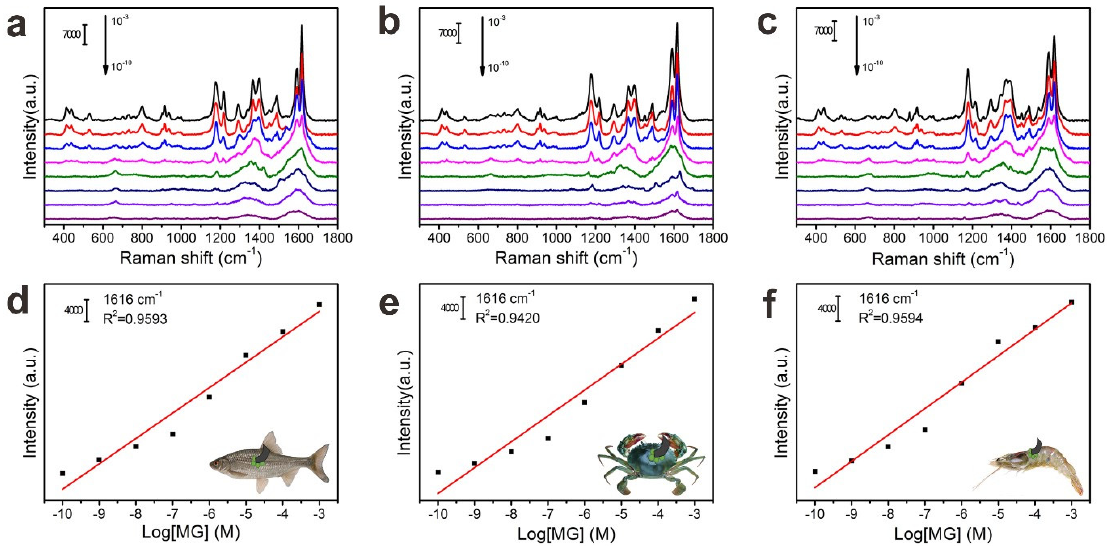
Figure 7. Spectra of MG with 10 − 3 M, 10 − 4 M, 10 − 5 M, 10 − 6 M, 10 − 7 M, 10 − 8 M, 10 − 9 M and 10 − 10 M concentrations collected from ( a ) fish scales, ( b ) crab shells and ( c ) shrimp skins using the FP@PDA@AgNPs strips by swabbing extraction. The linear plots between the SERS peak intensity at 1616 cm − 1 and the logarithm of MG concentration from ( d ) fish scales, ( e ) crab shells and ( f ) shrimp skin surface, using the FP@PDA@AgNPs strips by swabbing extraction.